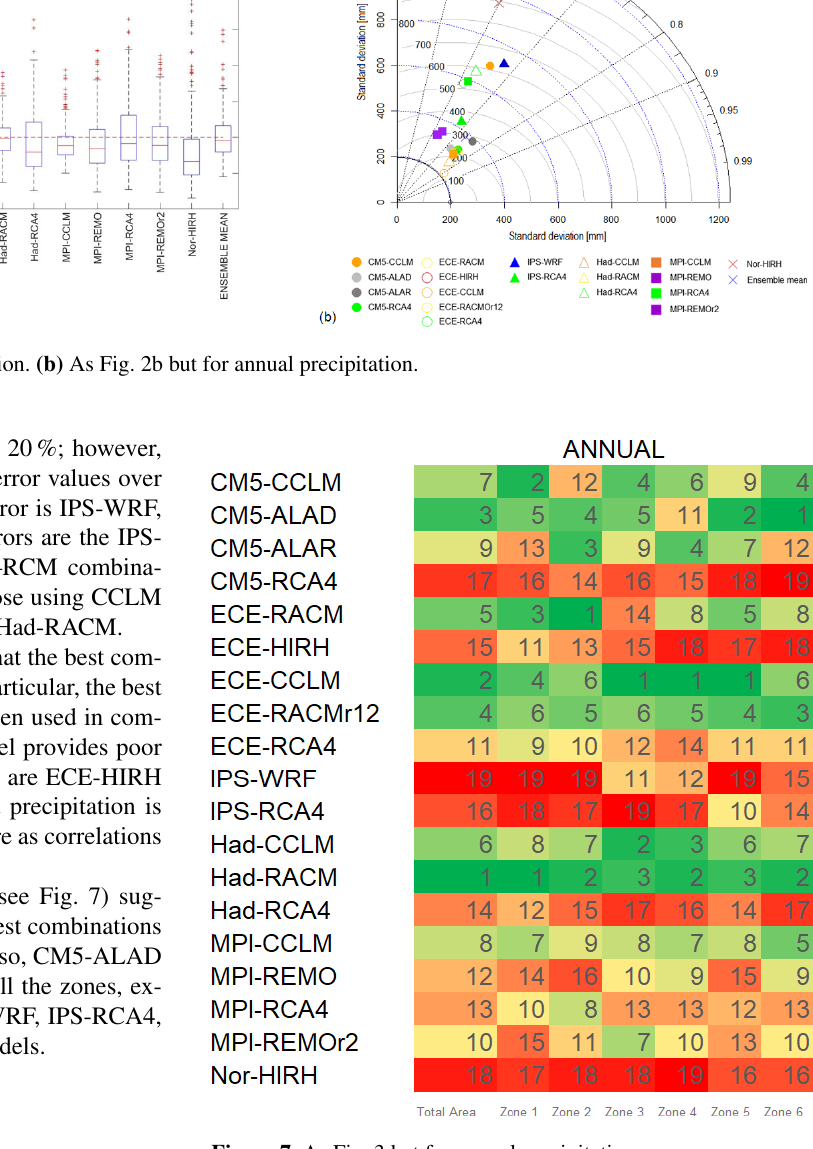
Figure 7. As Fig. 3 but for annual precipitation.